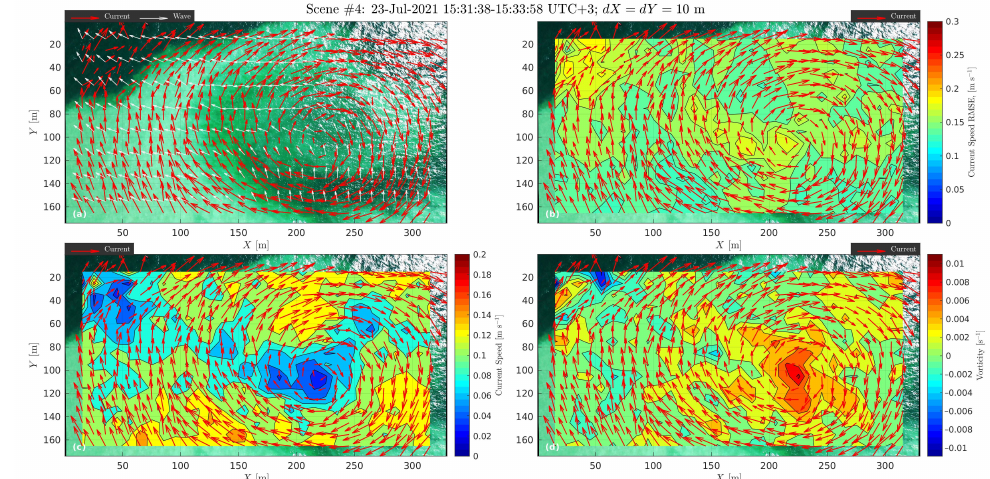
Figure 5. Scene #3: ( a ) sea surface current (SSC) and wave quiver maps; ( b ) SSC root-mean-square error (RMSE); ( c ) SSC speed; and ( d ) SSC vorticity. The SSC reconstruction using WDA successfully reproduced the anticyclonic circula- tion within the scene (Figure 6). The eddy had a 50-m diameter near-zero SSC “eye” which corresponds to the visual position of the eddy center. The maximum orbital velocity on the eddy periphery, ∼ 100 m away from the eddy core, was about 0.12–0.14 m s − 1 . Strong velocity gradients on such small spatial scales caused a peak in the vorticity field (Figure 6d) in the eddy center reaching 0.01 s − 1 , or about 100 f , indicating highly nonlinear dynamics of the eddy.